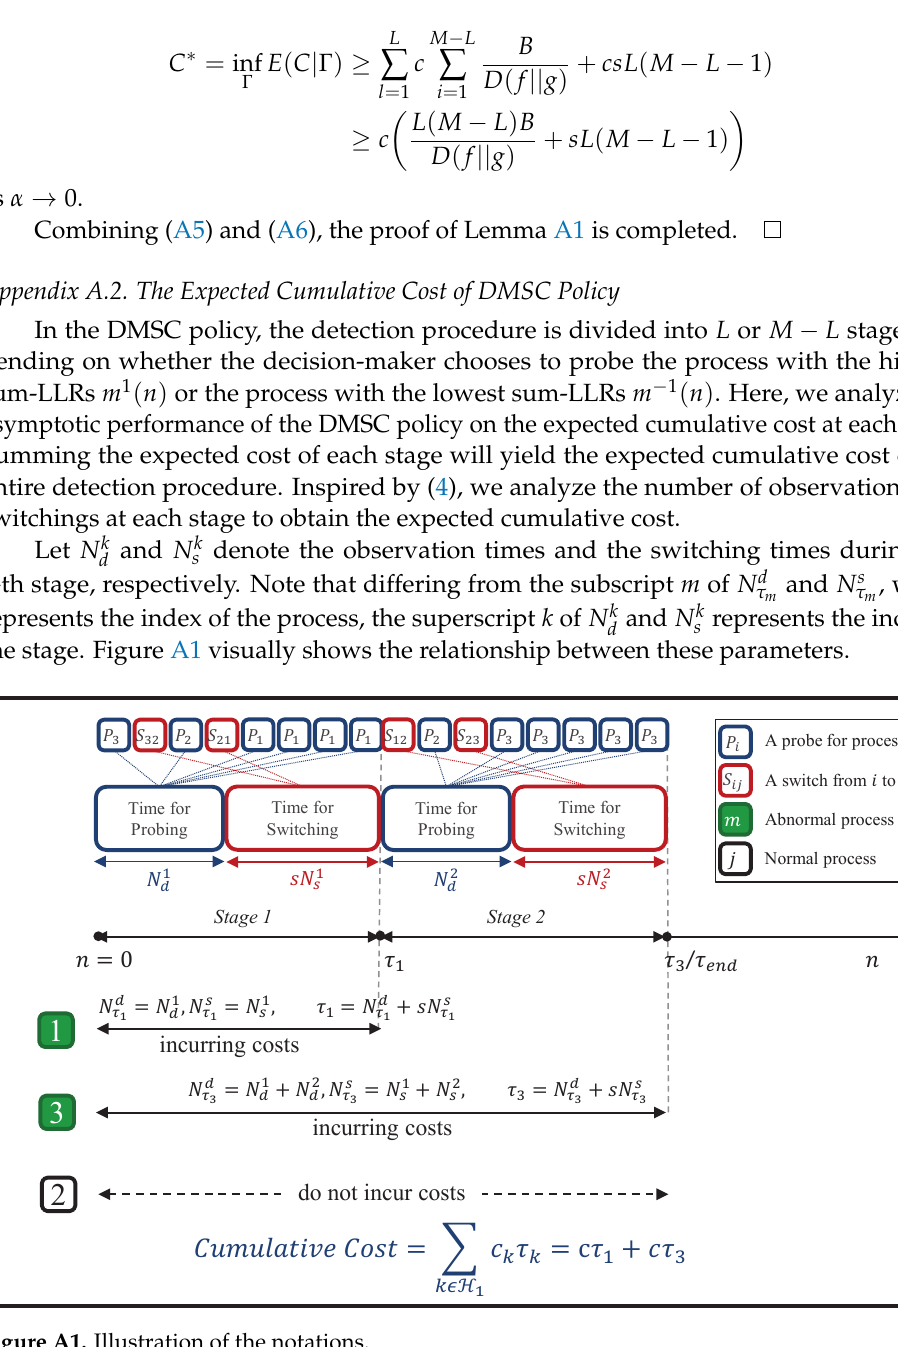
Figure A1. Illustration of the